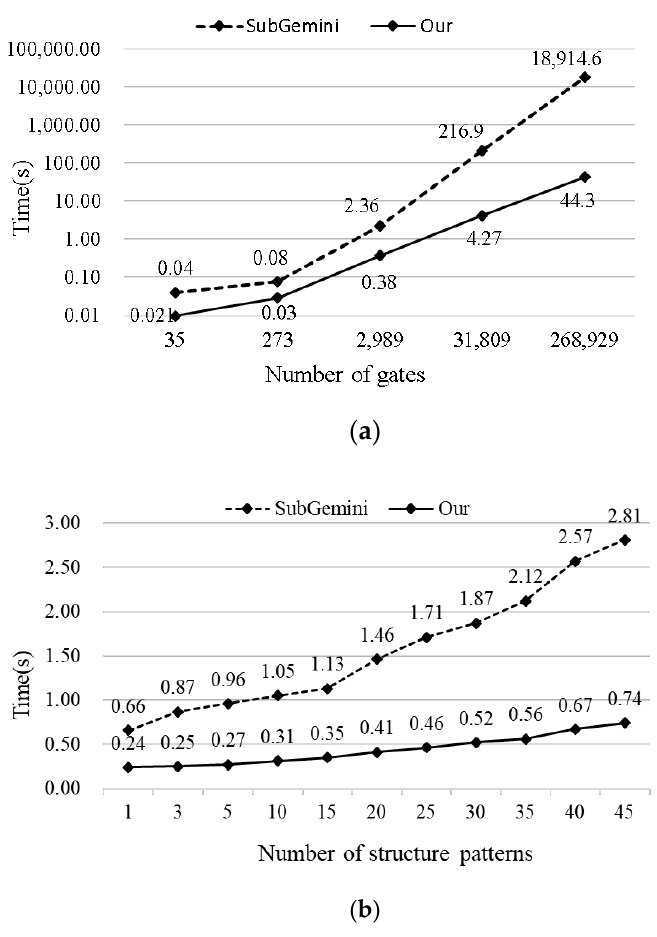
Figure 16. Efficiency comparison with graph-based method under growing of ( a ) design size ( b ) library size.